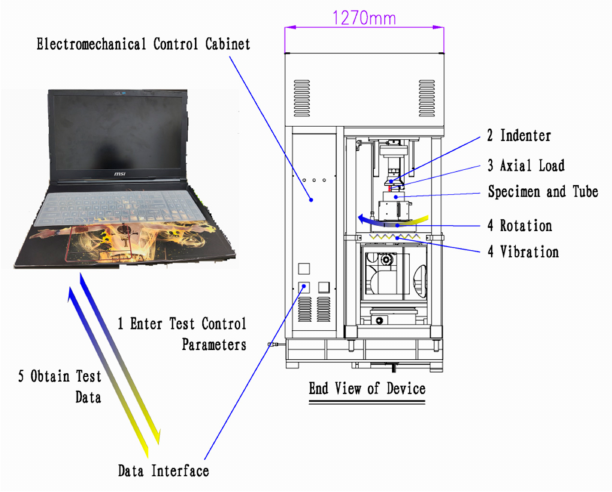
Figure 6. Schematic diagram of instrument loading